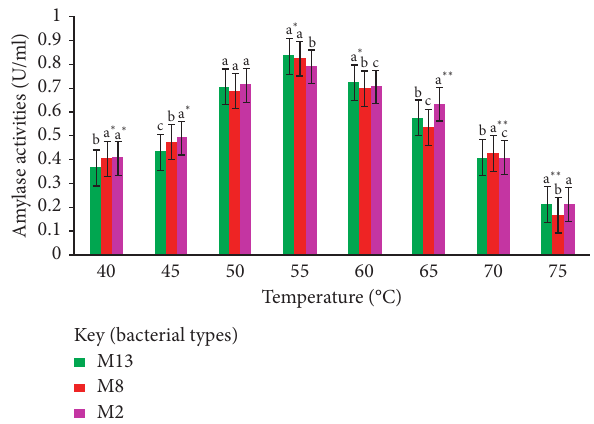
Figure 9: Effect of incubation temperature on the amylase pro- duction of M13, M8, and M2; mean values with the same letter are not significant ( P ≥ 0 . 05); ∗∗ significant at P ≤ 0 . 05.